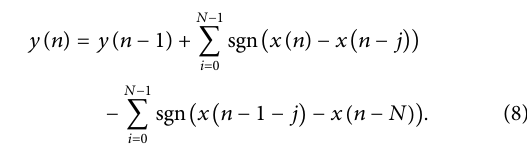
FIGURE 5 VOC concentration and copper temperature.